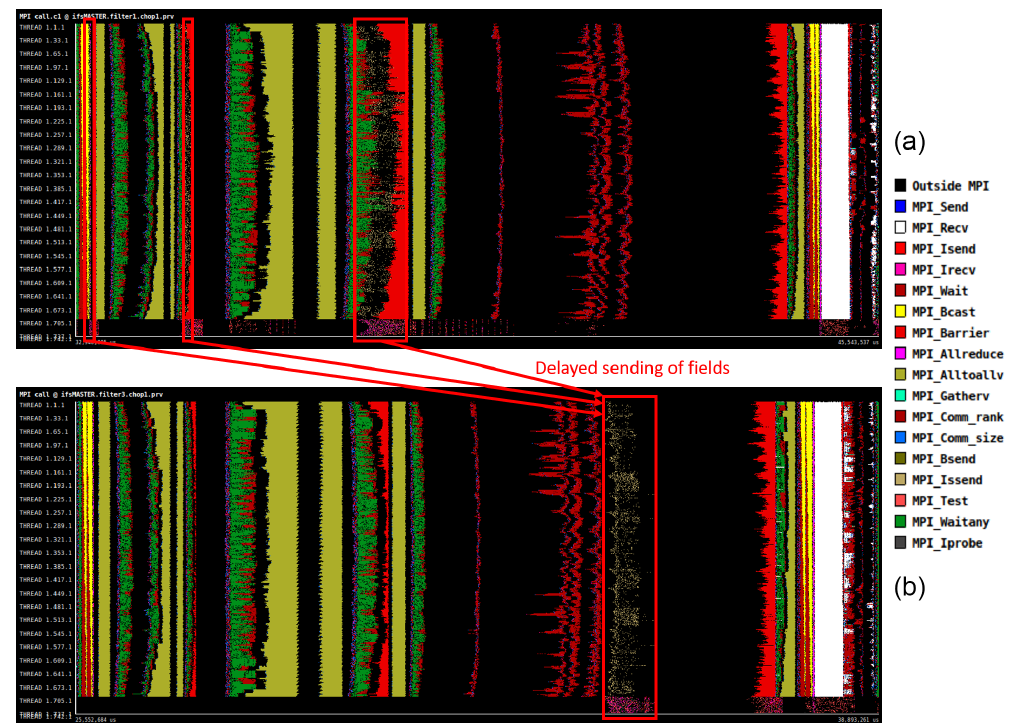
Figure 4. Panel (a) illustrates where fields are sent if the computation and communication overlapping optimisation is disabled, whereas panel (b) illustrates the delayed sending of the fields until the physics tendency computation if the optimisation is enabled. Table 1. Summary of the IFS CY43R3 configurations as run on the ECMWF Cray HPCF. AMIP HighResMIP Theoretical